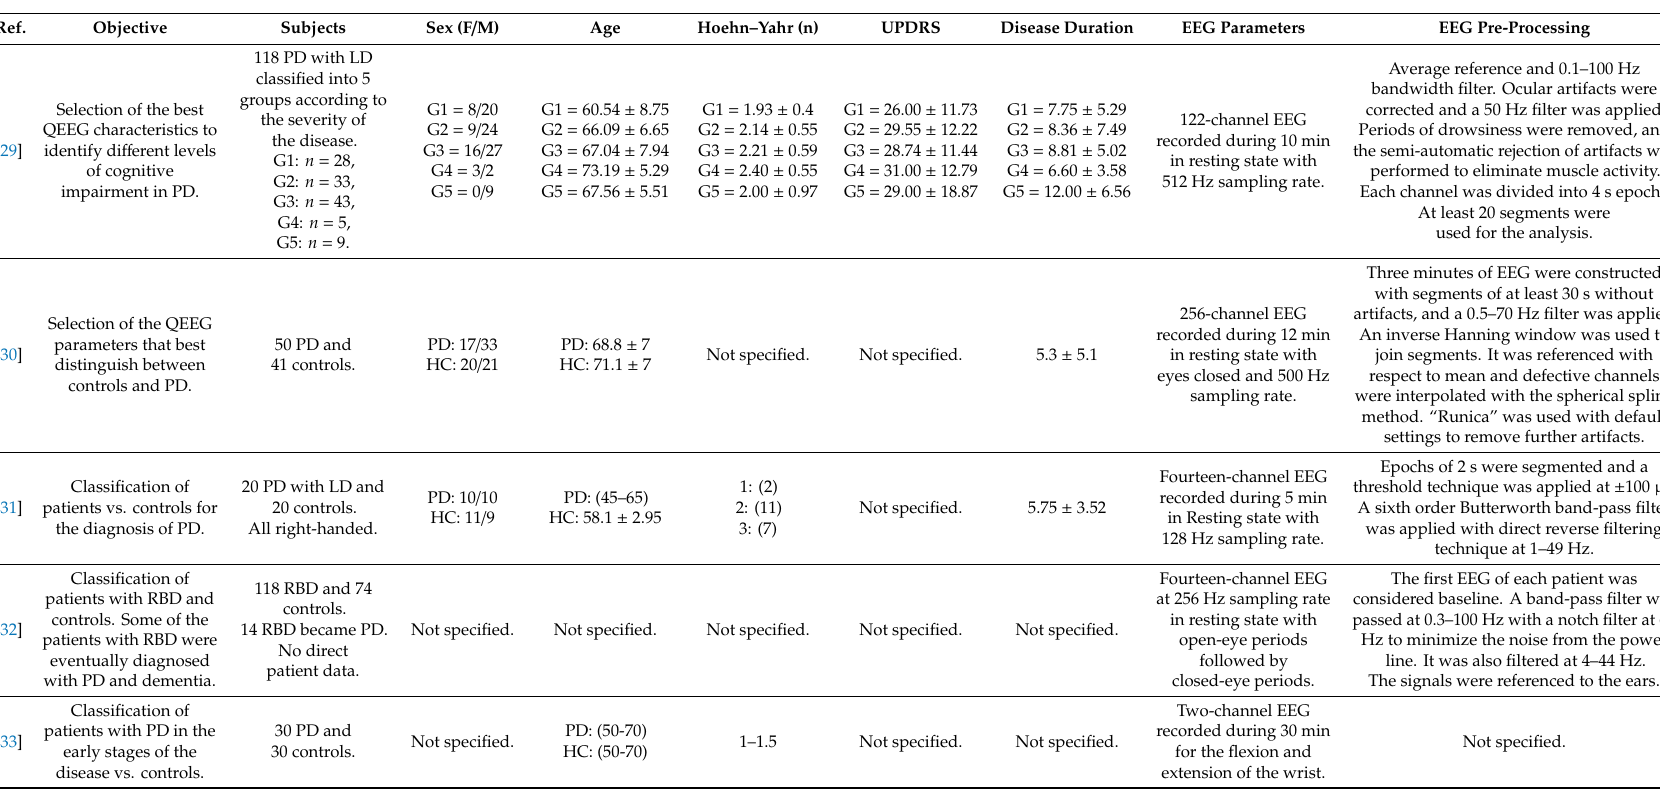
Table 2. Summary of the clinical variables, such as objectives, subjects, EEG recording protocol, EEG cleaning protocol and dataset pre-processing.